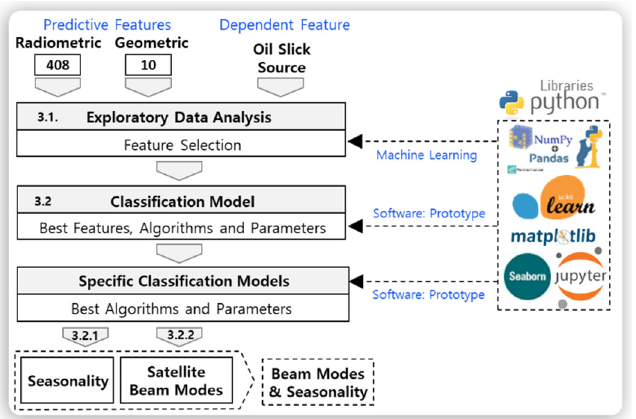
Figure 4. Proposed methodology indicating the Python libraries employed for the software building, with the discussion of results organized per item.